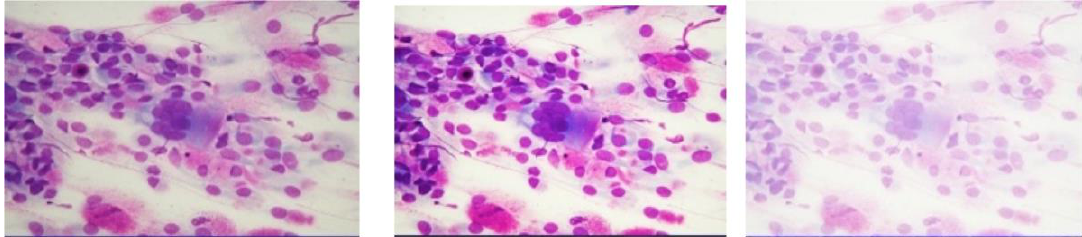
Figure 3. Image Enhancement. Original image (on the left); image with contrast enhancement (in the center); image with brightness enhancement (on the right) that needs gamma-correction.